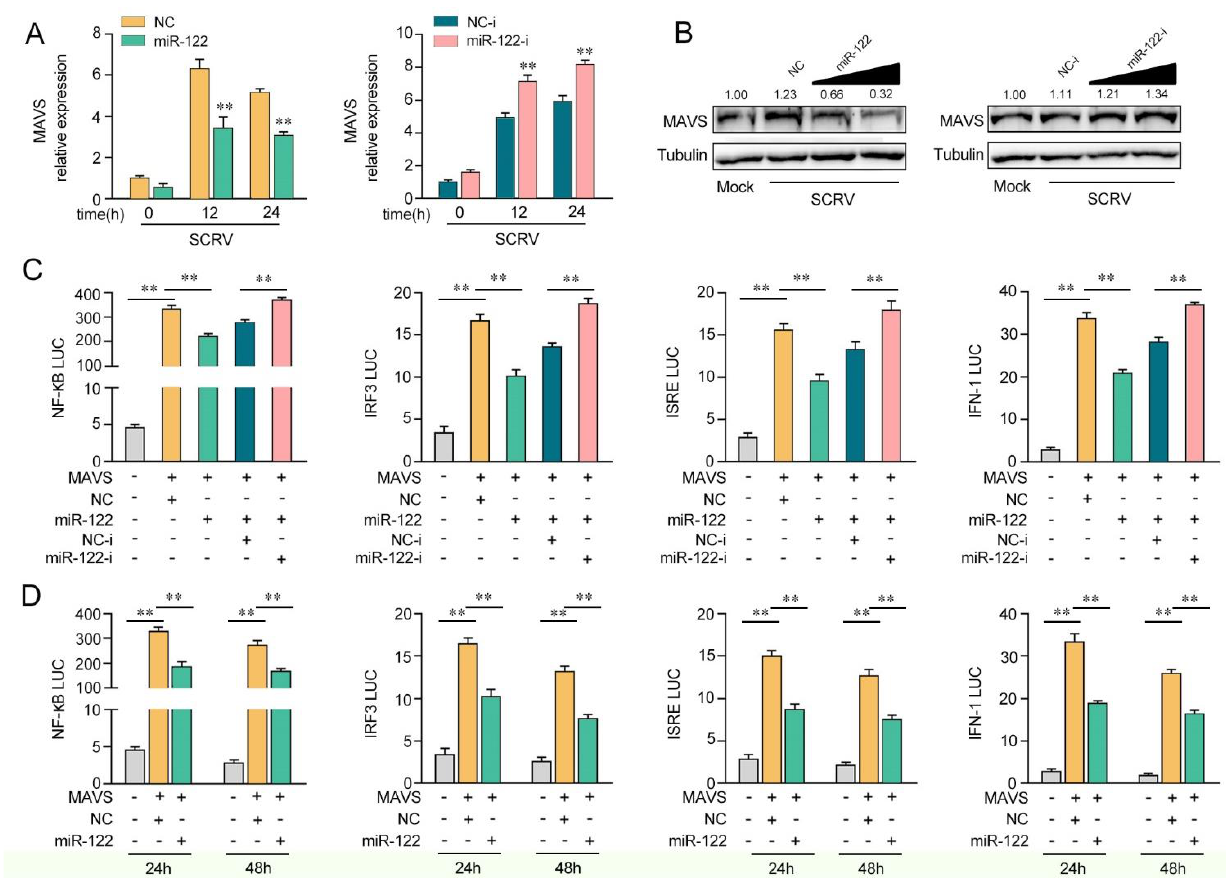
Figure 4. miR-122 is able to suppress MAVS-mediated antiviral signaling. ( A ) The qPCR assays were conducted to measure the expression levels of MAVS in MKCs by transfection with miR-122 or NC, miR-122-i, or NC-i upon SCRV treatment. ( B ) MKCs were cotransfected with miR-122 (0, 25, 50, and 100 nM) or NC (100, 75, 50, and 0 nM) and miR-122-i (0, 25, 50, and 100 nM) or NC-i (100, 75, 50, and 0 nM) for 24 h. Then, the cells were treated with SCRV for another 24 h, and the protein levels of MAVS were measured by Western blotting. ( C ) EPC cells were cotransfected with miR-122 or NC and miR-122-i or NC-i, along with MAVS expression plasmid, pRL-TK vector, NF- κB, IRF3, ISRE, or IFN-1 luciferase reporter genes to investigate the regulatory role of miR-122 on NF- κB and IRF3 signaling. For each transfection, the total amount of oligonucleotides was controlled and normalized (final concentration, 100 nM). ( D ) EPC cells were cotransfected with miR-122 or NC, MAVS expres- sion plasmid, and pRL-TK vector, together with NF- κB, IRF3, ISRE, or IFN -1 luciferase reporter genes for 24 and 48 h, and then the luciferase activity was determined. Luciferase activity was nor- malized to Renilla luciferase activity. All data are presented as the means ± SE from at least three independent triplicate experiments. **, p < 0.01 for the controls.